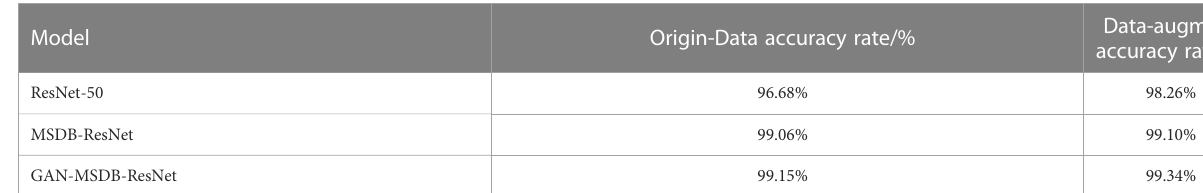
TABLE 3 Accuracy of different approaches.